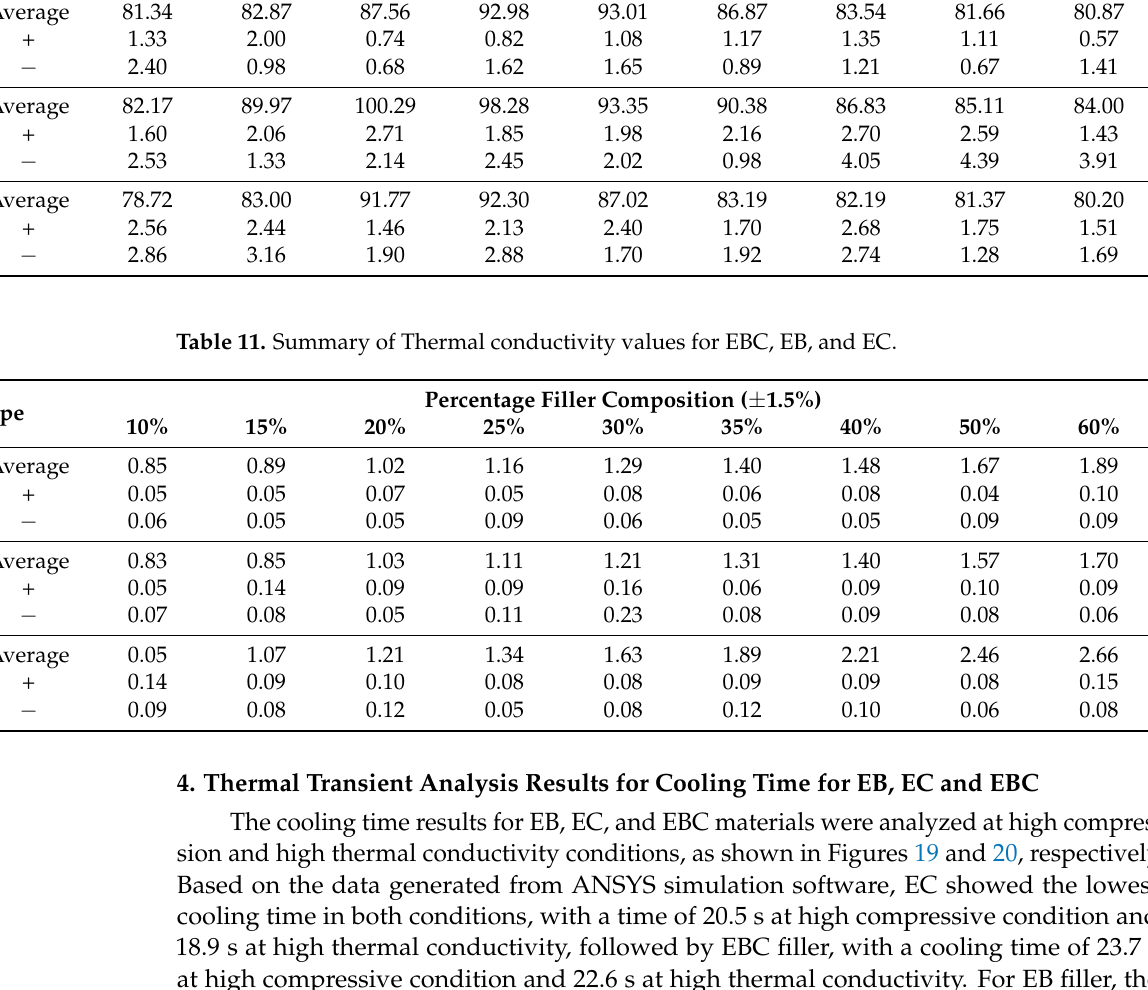
composition. Under this condition, an increase in thermal conductivity of 1.29 W/m·K for